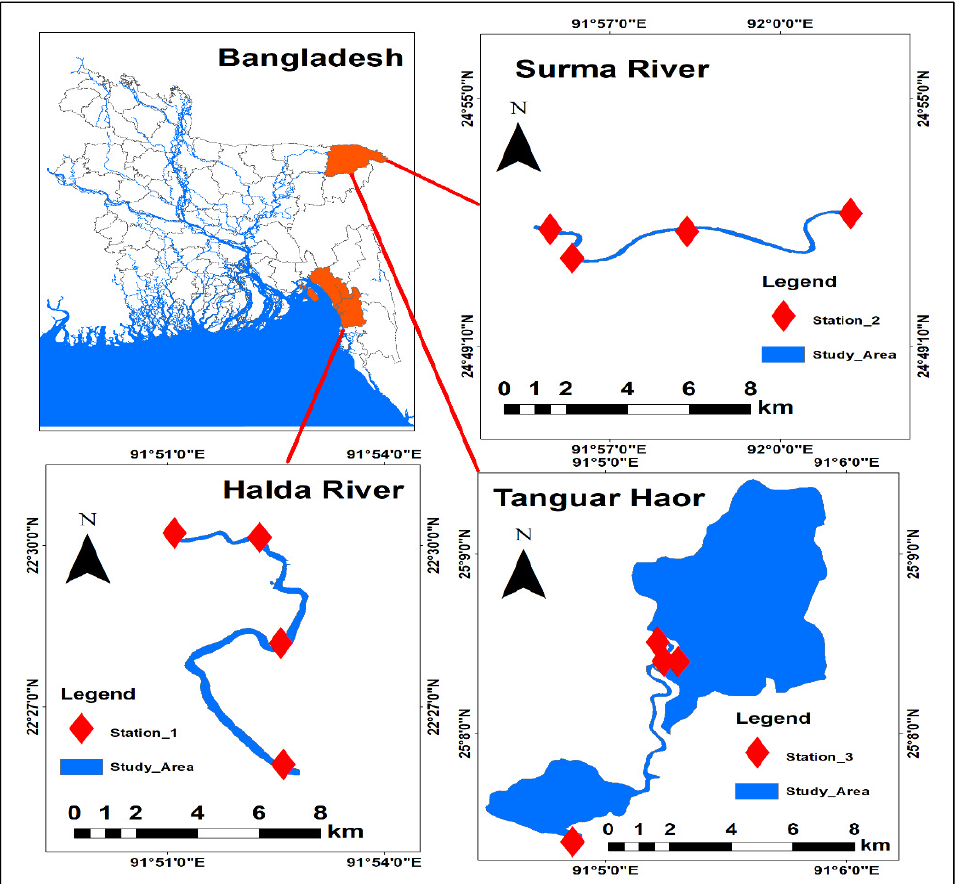
Figure 1. Map showing sampling stations in the study area at the Halda River and Haor basins of Sylhet.